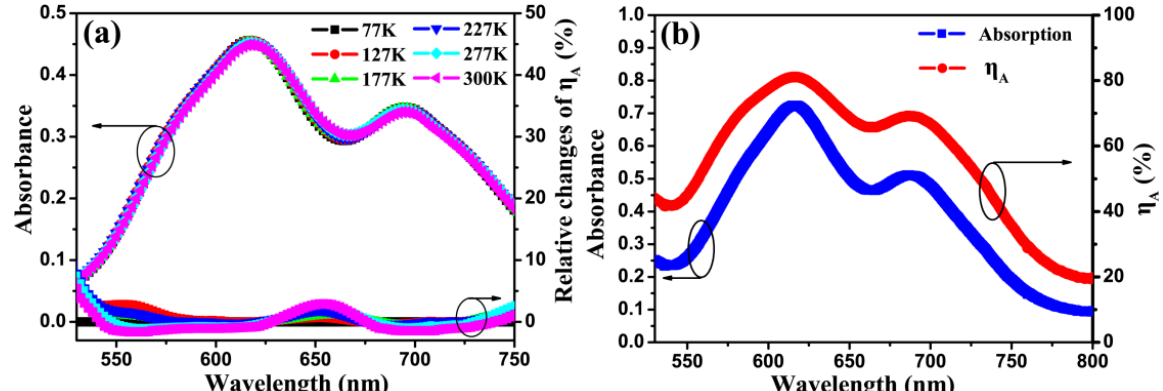
Figure 4. ( a ) Absorption spectra for a 50 nm CuPc thin film thermal evaporated on quartz substrate and the relative changes of absorption efficiency ( η A ) at different temperatures. ( b ) The absorption spectra and η A of the developed OSC device at 300 K.